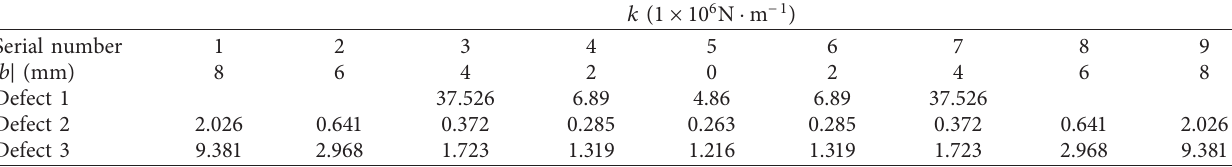
Table 3: Measured values of tapping response pulse width at different positions in the defective area.